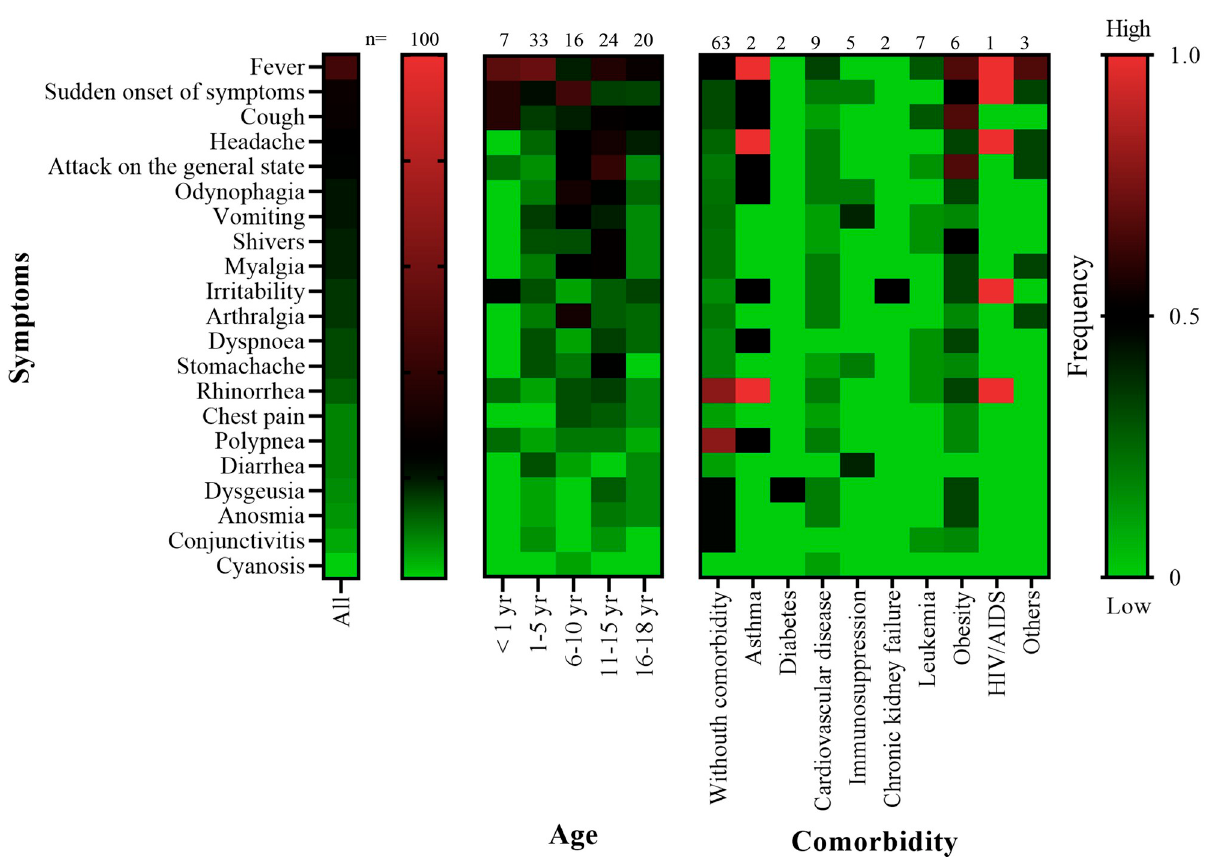
Fig 1. Distribution of symptoms, age, and comorbidities in Mexican children and adolescents with COVID-19. Heat map showing the frequency of symptoms in Mexican children and adolescents with COVID-19 (left panel) and their age and the comorbidities. The total number (n) of patients with COVID-19 is shown on the top of the figure, and the number of patients corresponding to each age category or presenting any comorbidity is displayed. The frequency scale of the variables is shown at the right. The color map was prepared with a double gradient, where the largest value is represented in red (100%), baseline value is represented in black (50%), and smallest value is represented in green (0%).